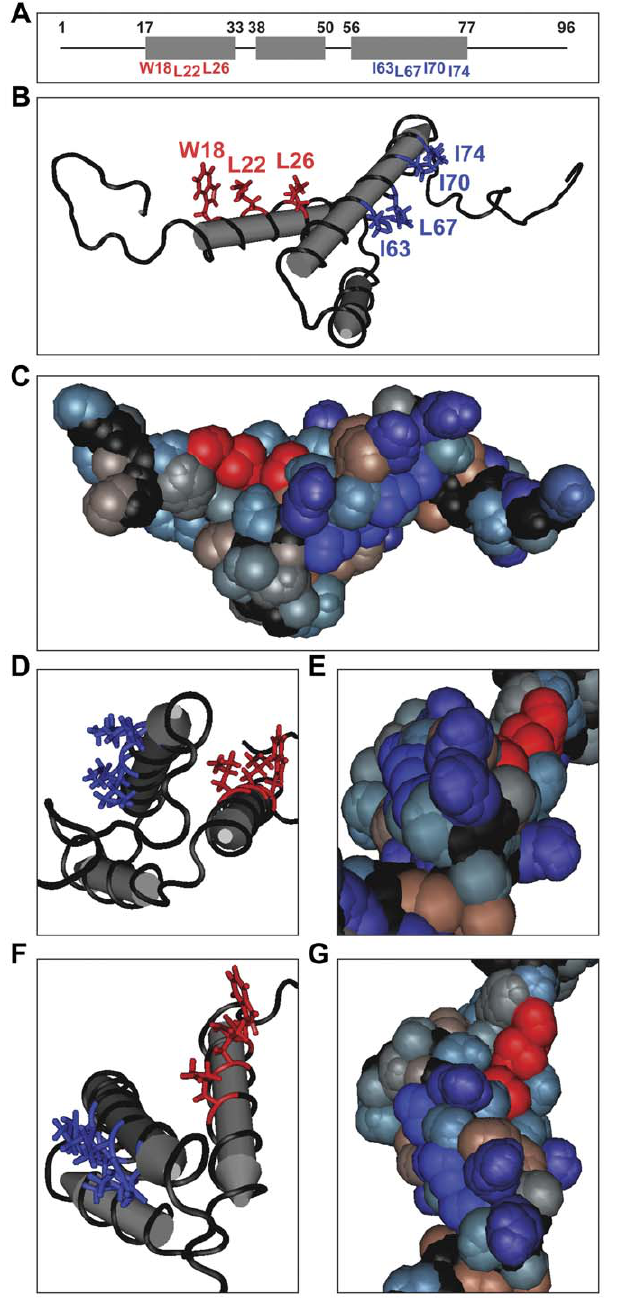
Figure 2. Hydrophobic residues on Vpr helix-1 are important for incorporation into virions. ( A ) 293T cells were co-transfected with pcDNA3-hVpr plasmids expressing WT or mutant Vpr (or the empty vector control), pLVSV-G, and pNL4-3 e-n-GFP RTm, Vpr D 22-86 to produce virus for virion delivery of Vpr. At day 2 the virus stocks were harvested and the 293T cells were lysed. Western blot indicates protein levels for WT or mutant Vpr (bottom). A western blot for b -actin is used as a loading control (top). ( B ) Lysates were prepared from the virus stocks in (A). Viral lysates were analyzed for protein levels of WT or mutant Vpr by western blotting as in (A) (bottom). The HIV-1 p24 capsid (p24 CA) is shown as a protein loading control (top). ( C ) Densitometry of all bands in (B) was performed. The intensity of the Vpr protein band was normalized to p24 CA and plotted as % Vpr incorporation relative to WT Vpr for each mutant. The data are shown as the mean 6 the standard deviation of three independent experiments.